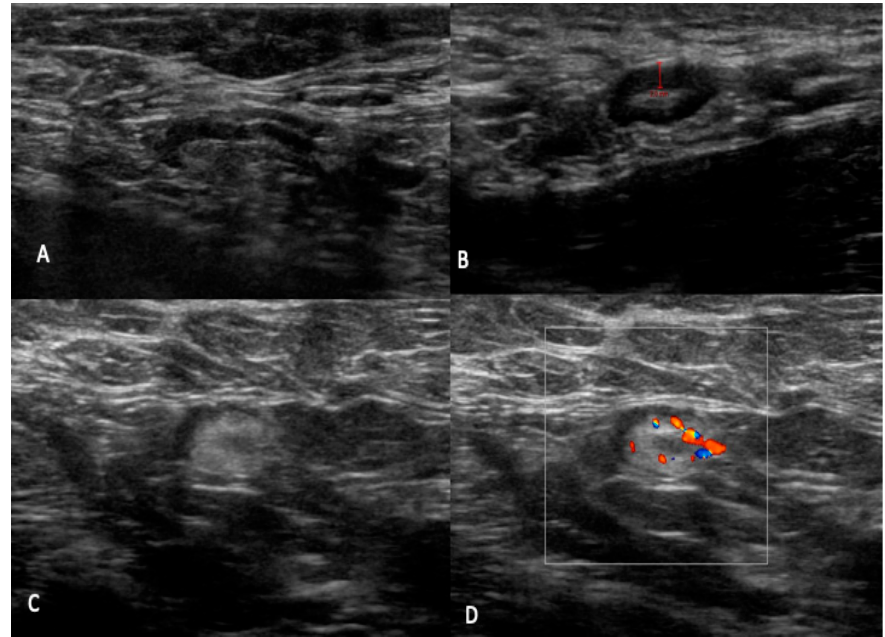
Figure 2. UN2: ( A – D ) B-mode sonogram image shows an oval node with uniform cortical thickening (<3 mm), centrally placed fatty and vascular hilum (color flow